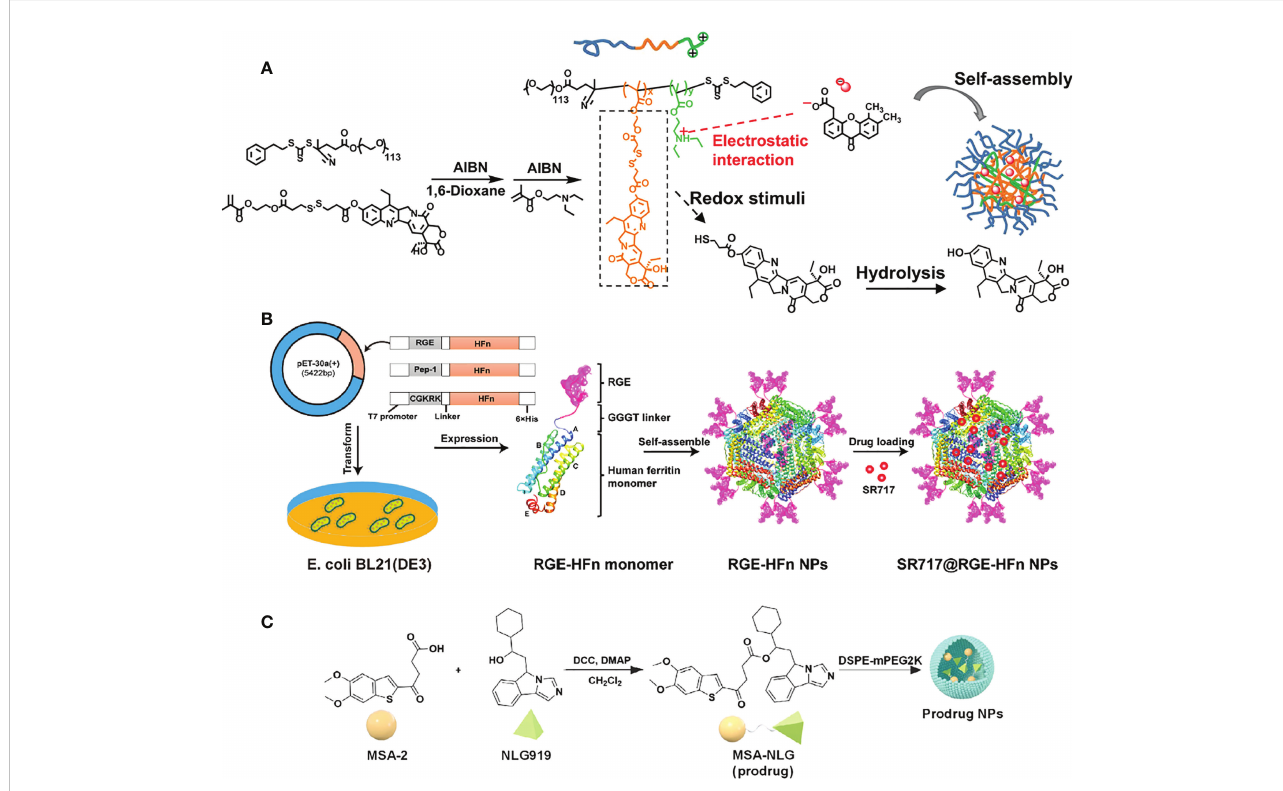
FIGURE 5 Nanomedicine loaded with non-nucleotidyl STING agonists for tumor immunotherapy. (A) Schematic illustration of the polymer nanoreactor (D/G@PFC) co-loaded with DiABZI and GOD via self-assembly in aqueous solution at pH 7.4. Nanopolymer membranes are responsive to the acidic pH of tumors. Reproduced from Ref. (62) with permission. Copyright 2021 John Wiley & Sons. (B) Schematic illustration of SR 717@RGE-HFn NP with dual targeting strategy to achieve an effective anti-glioma immune response. Reproduced from Ref. (64) with permission. Copyright 2022 ELSEVIER. (C) Schematic diagram of the synthesis of prodrug (MSA-NLG) obtained by encapsulating MSA-2 with DSPE-mPEG2K. Reproduced from Ref. (66) with permission. Copyright 2022 Springer